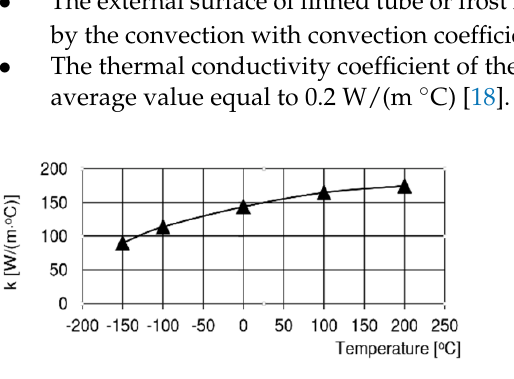
Figure 6. Thermal conductivity of aluminum alloy [19].